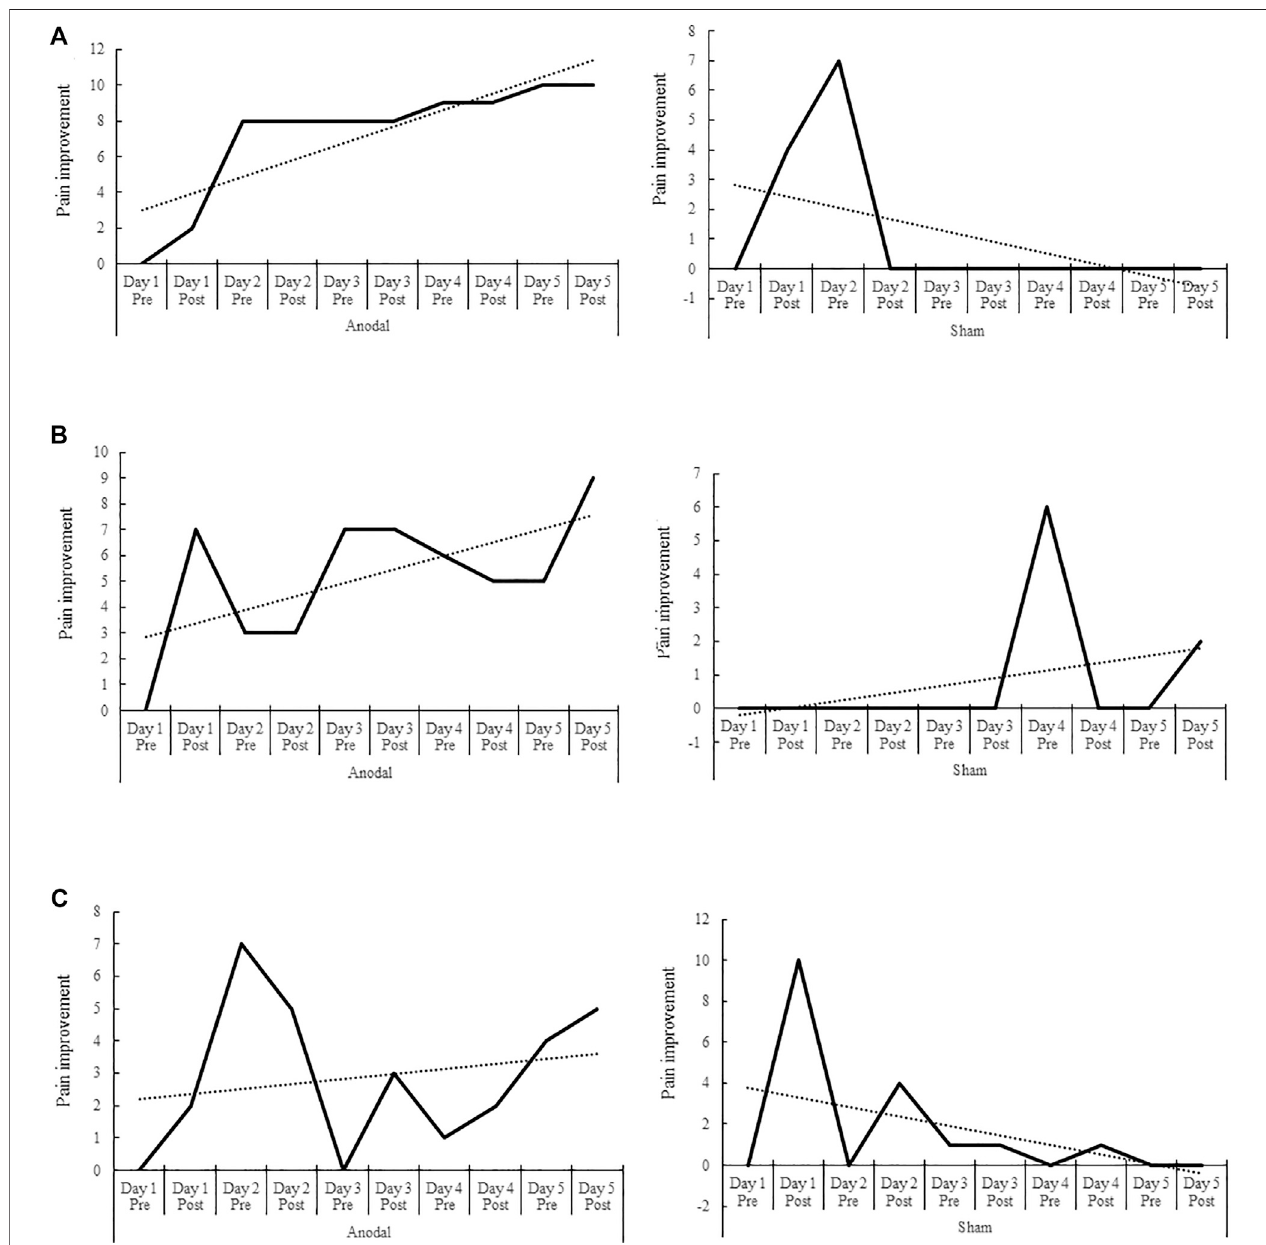
FIGURE 3 | Pre- and post-anodal and sham tDCS values of pain improvement of the Adaptive Visual Analog Scales of pain intensity and improvement (AVAS) for each of the three patients (A – C) throughout the fi ve intervention sessions (day 1 – 5). The dotted line represents the data trend. Signi fi cant differences between the pain improvement meanvalues oftheanodal and sham stimulation conditions werefoundin patients 1and 2,withsuperiorimprovements after anodal stimulation ( p < 0.001 and p (cid:2) 0.001, respectively). The differences between the mean values of the anodal and sham conditions in patient 3 were not signi fi cant, although there was a trend toward signi fi cance ( p (cid:2)